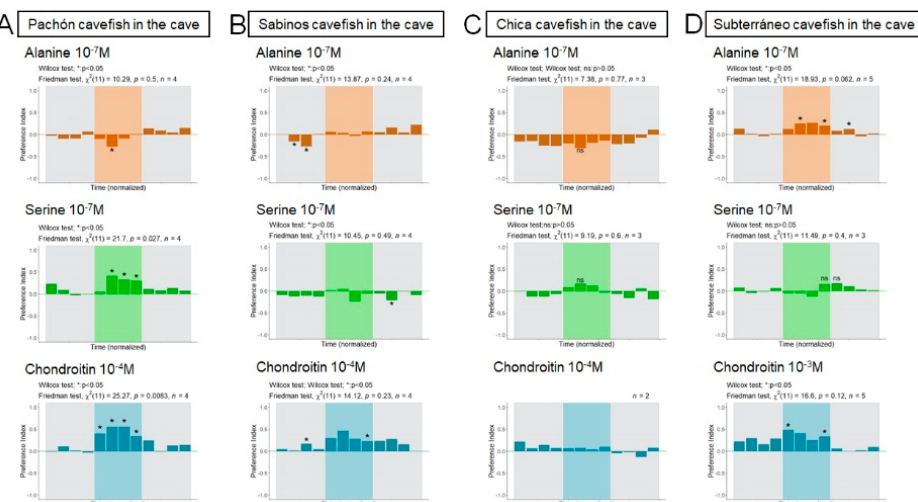
Figure 6. Olfactory responses of cavefishes in natural cave settings; ( A – D ) Olfactory responses recorded in the Pachón ( A ), Sabinos ( B ), Chica ( C ), and Subterráneo ( D ) caves; Odors and concentrations are indicated, as well the number of replicates. The preference index (PI; positive values suggest attraction) is shown as a function of time. Time intervals corresponding to odor perfusion are shaded. Asterisks on graphs indicate significance as compared to no response (i.e., PI = zero) for a given time interval (Mann–Whitney test). The results of Wilcoxon and Friedman tests to probe the significance of the response across time with repeated measures are also